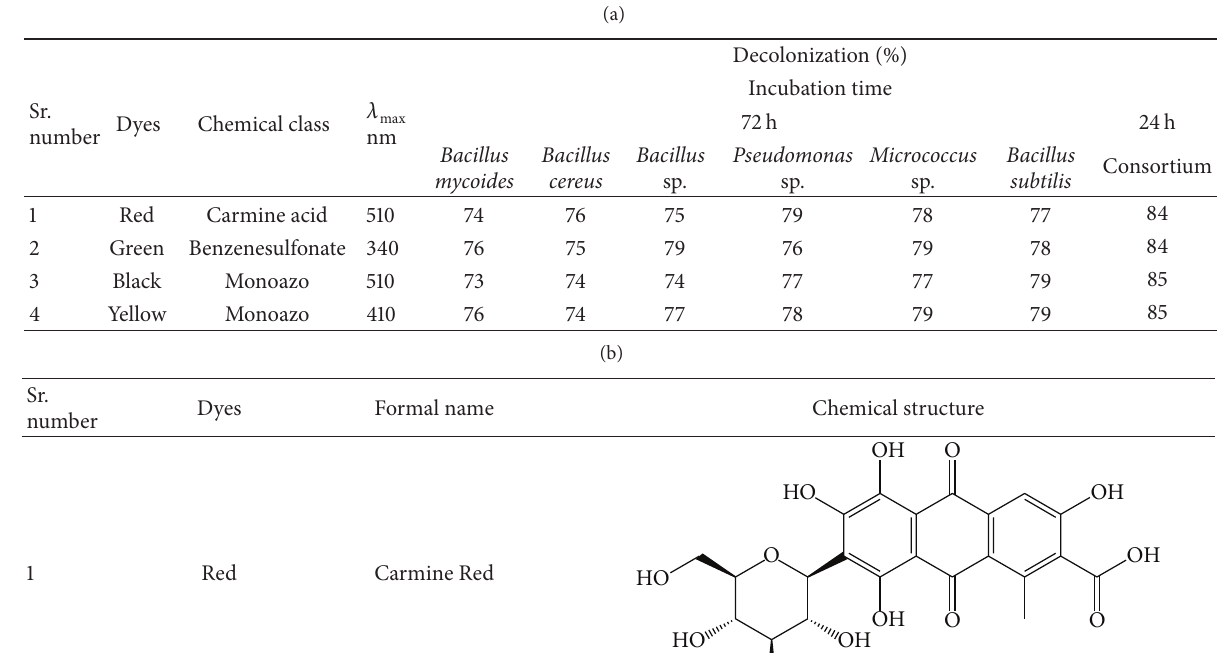
Table 1: (a) Comparison of dye decolonization by different isolates from textile industry effluent. (b) Formal names and chemical structures of dyes used during decolorization.